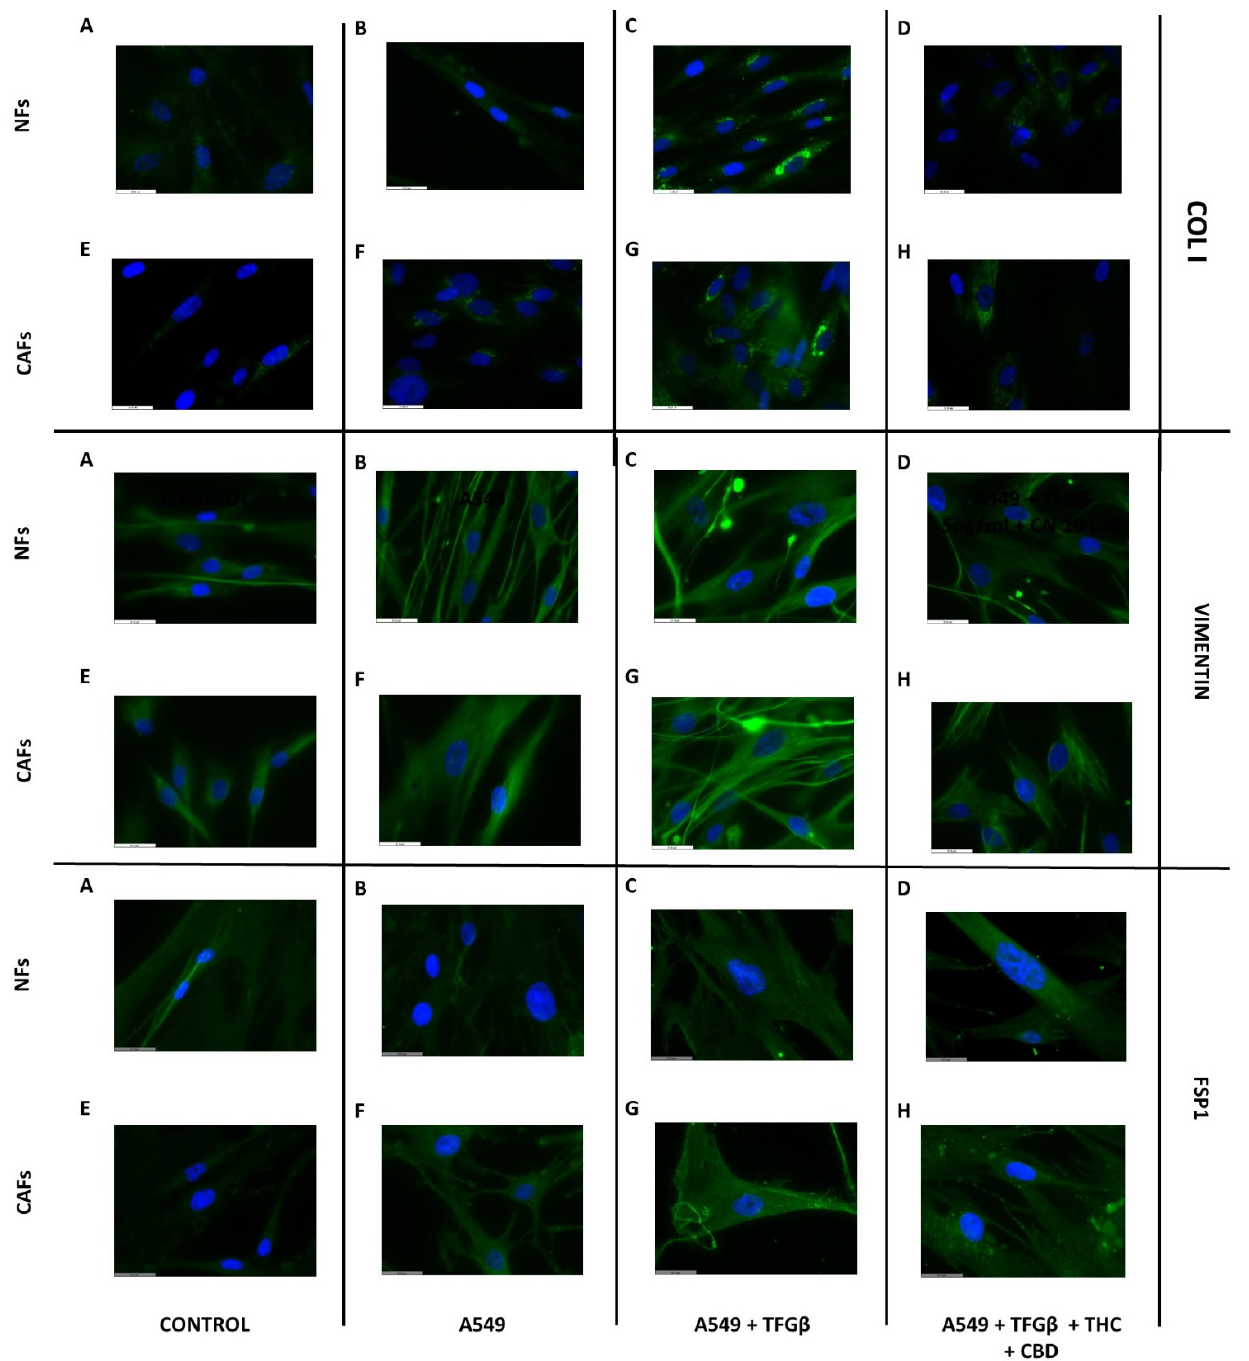
Figure 6. Effect of cannabinoid agonists on stromal cell cytoskeletal changes induced by A549- cell-conditioned medium. NFs or CAFs were cultured for 72 h with non-conditioned culture medium ( A , E ), A549-cell-conditioned medium (A549CM, ( B , F )), A549CM + 5 ng/mL TGF β ( C , G ) or A549CM + 5 ng/mL TGF β + an equimolar mixture of 10 µ M THC + CBD ( D , H ). Type I collagen, vimentin and FSP1 were studied by immunofluorescence. Representative fluorescence images corre- sponding to 3 different experiments are shown. A triplicate was analyzed in each of the experiments. Scale bar is equal to 31.5 µ